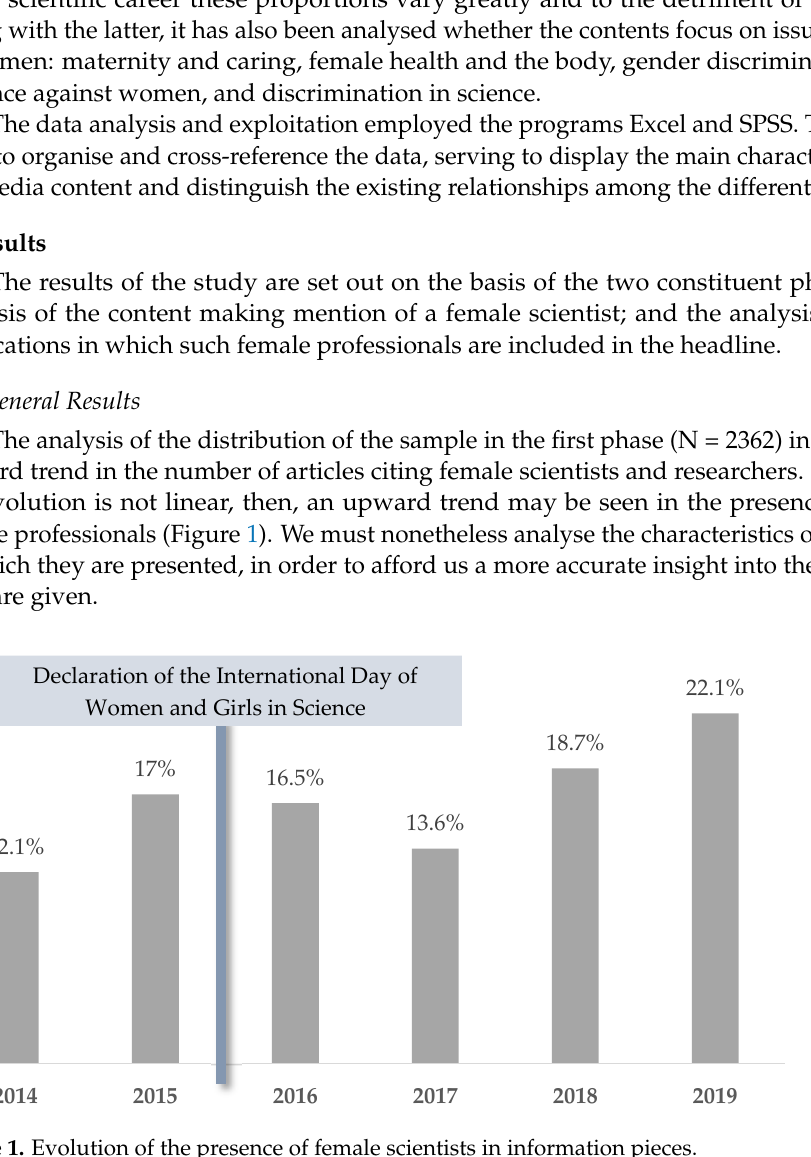
Figure 1. Evolution of the presence of female scientists in information pieces.